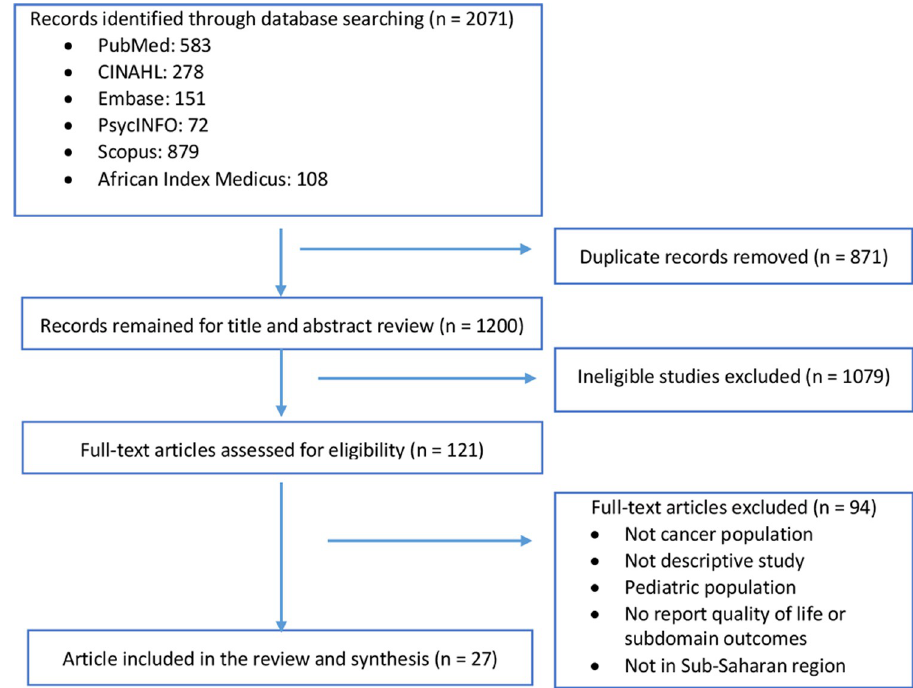
Fig 1. PRISMA flowchart of study identification and